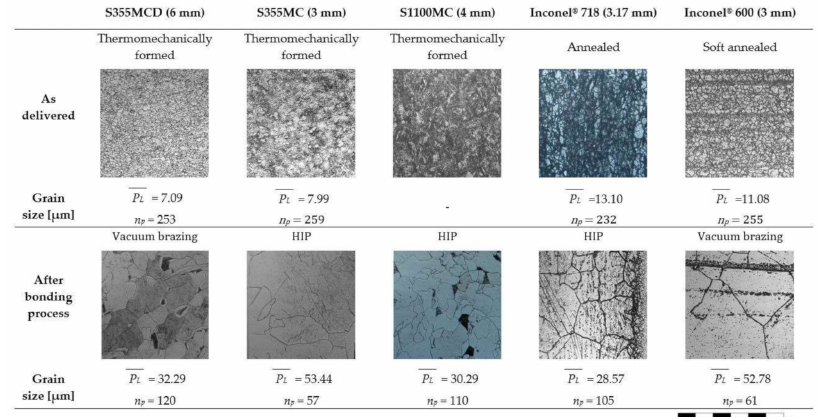
Figure 7. Microstructures of the test specimens ( n p = number of intersections).